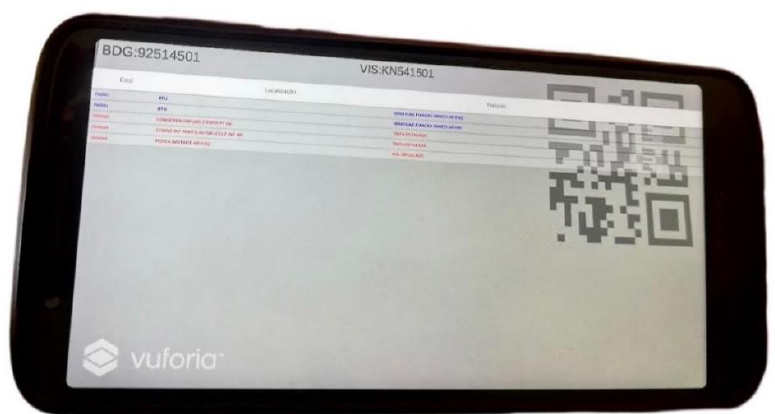
Figure 8. System execution on an Android device.